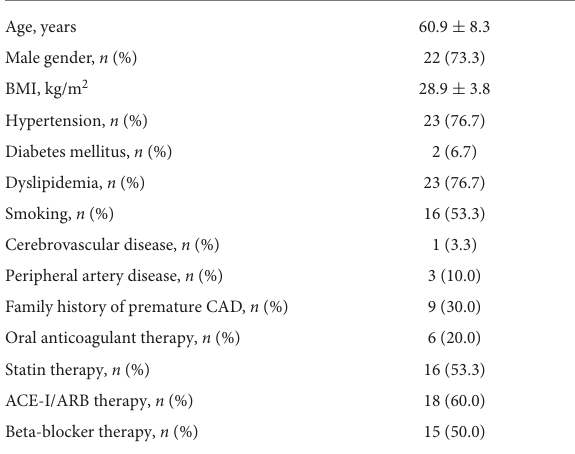
TABLE 1 Patient